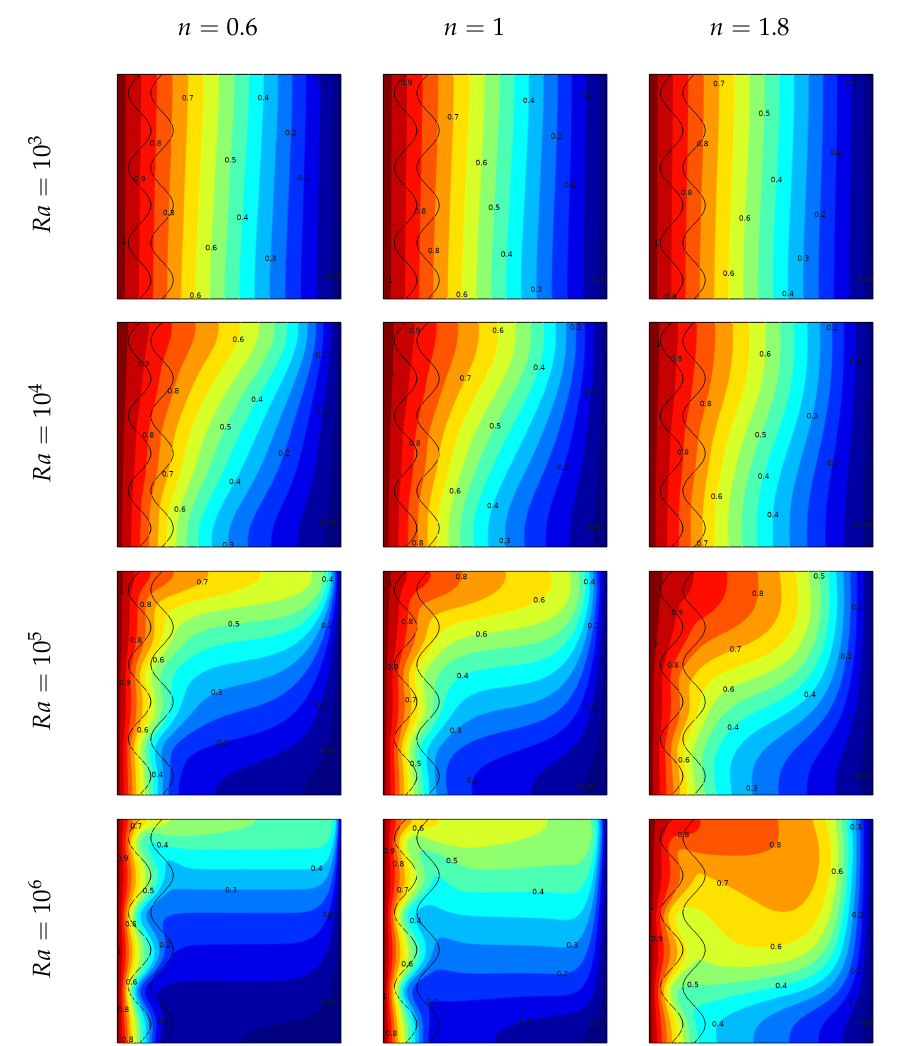
Figure 4. Isotherms for different values of power law indices n and Rayleigh numbers Ra